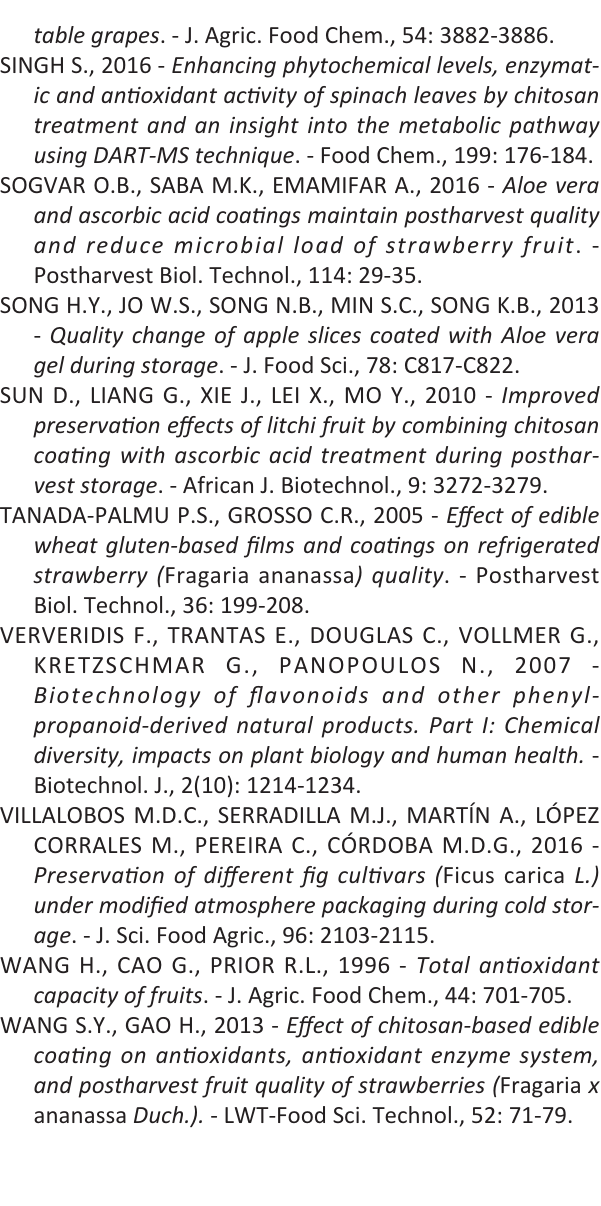
table grapes . ­ J. Agric. Food Chem., 54: 3882­3886. SINGH S., 2016 ­ Enhancing phytochemical levels, enzymat‐ ic and antioxidant activity of spinach leaves by chitosan using DART‐MS technique . ­ Food Chem., 199: